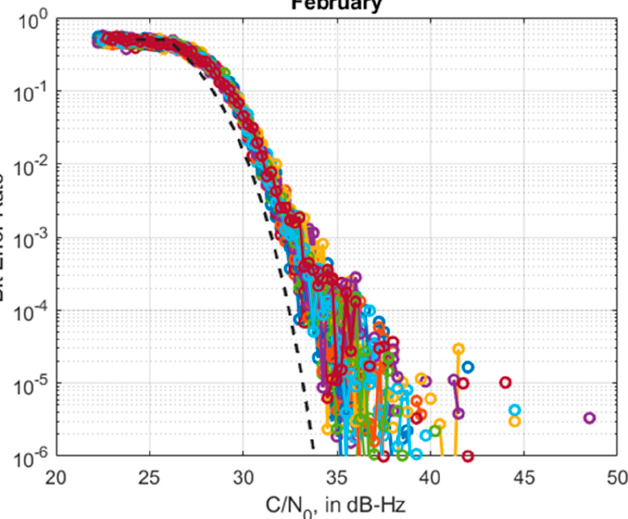
Figure 6. Daily BER versus C / N 0 for the month of February 2021. The dashed black line represents the theoretical BER curve assuming Gaussian noise. Different colors refer to different days of the month.